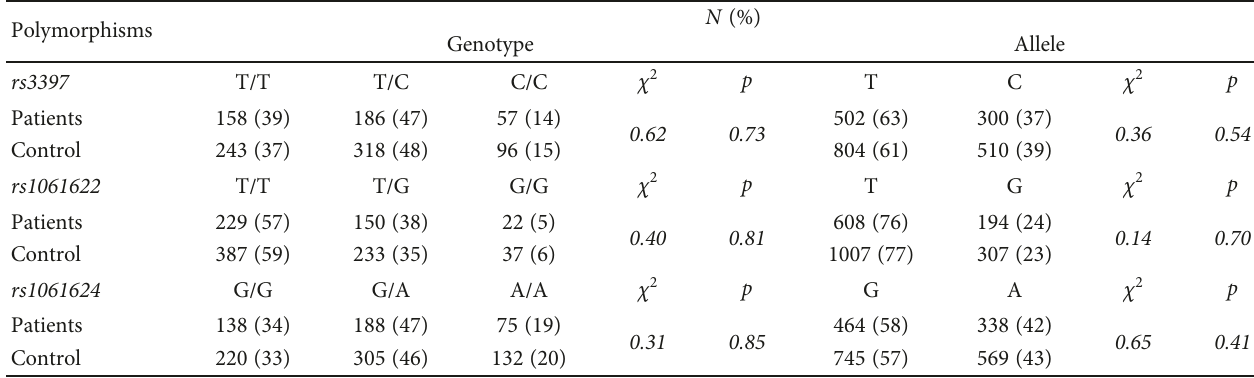
Table 1: Genotype and allele distributions for the TNFR2 (rs3397, rs1061622, and rs1061624) polymorphisms in paranoid schizophrenia patients ( n = 401 ) and control subjects ( n = 657 ).